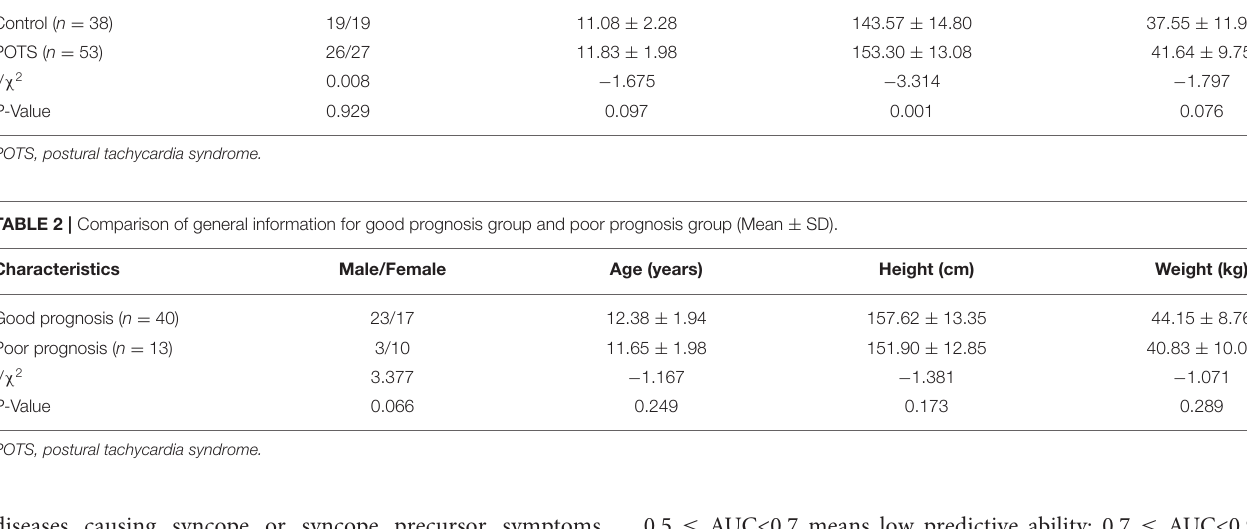
TABLE 1 | Comparison of general information for control group and POTS group (Mean ± SD). Characteristics